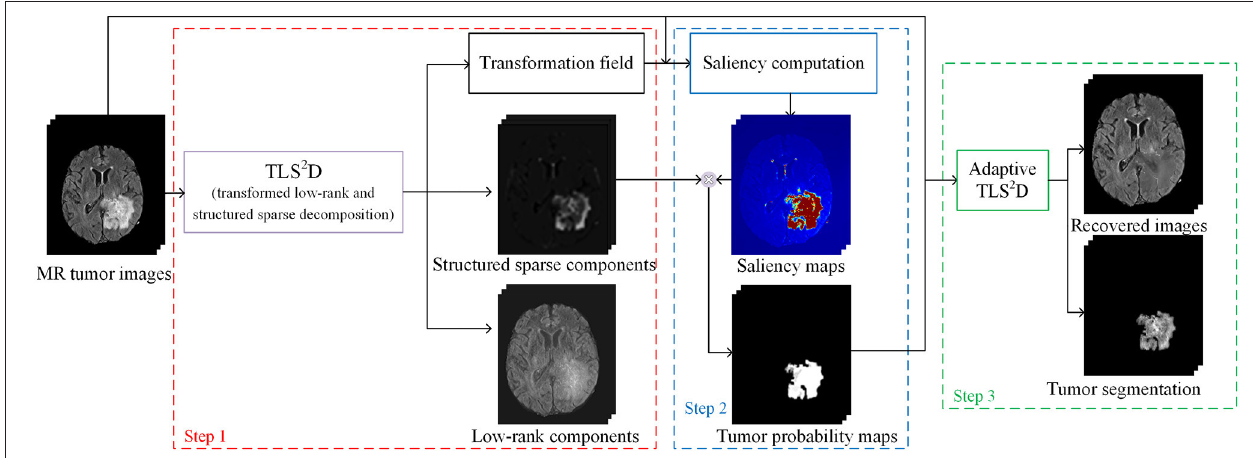
FIGURE 2 | The illustration of the whole recovery and segmentation framework using the proposed transformed low-rank and structured sparse decomposition (TLS 2 D)